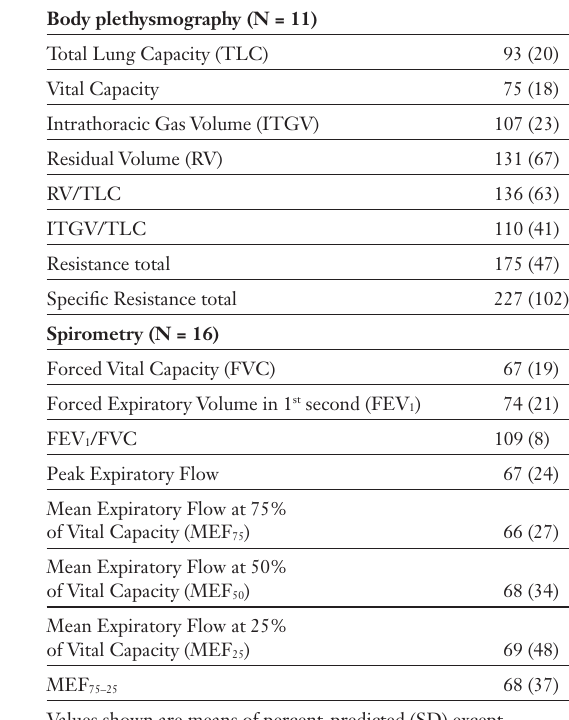
Apgar score at 5